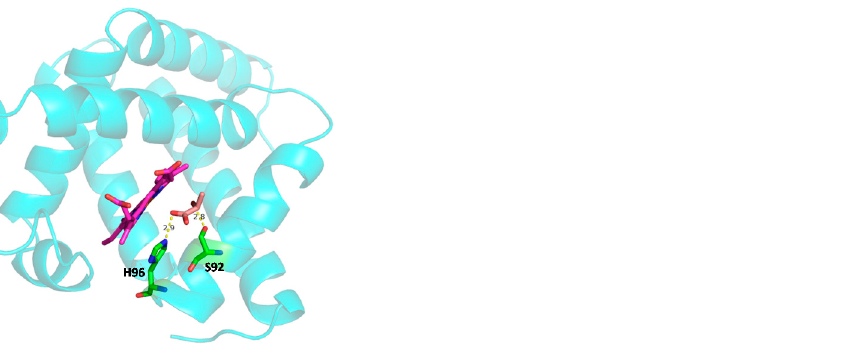
change in acidic pH (pH 6.4 and pH 6.0), LAC is docked near to proximal His side of heme center